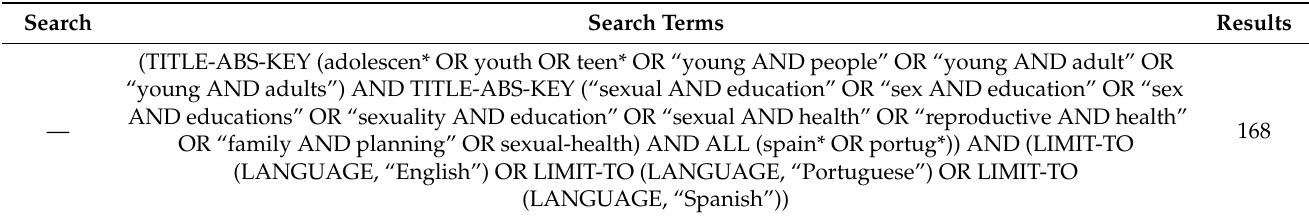
Table A7. Search at Scopus in 6 April